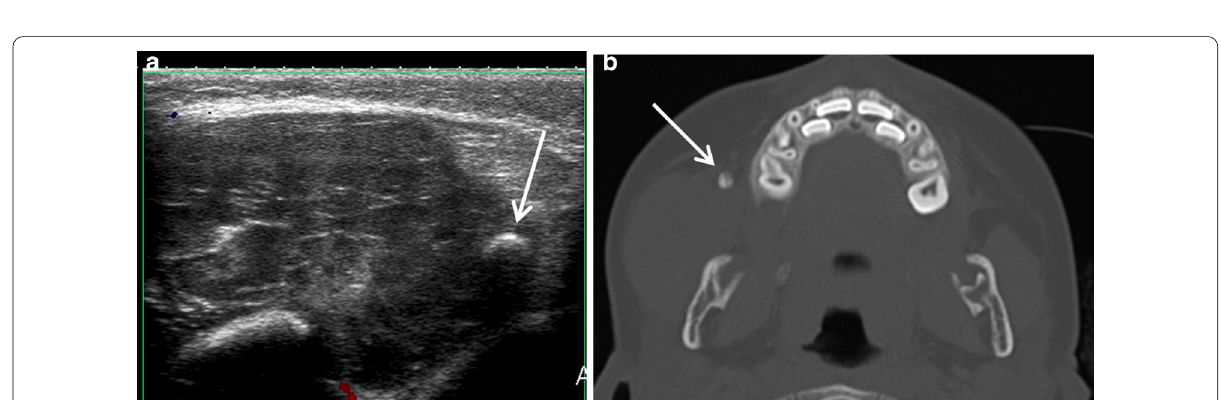
Fig. 24 Venous malformation in the right masseter, with a typical phlebolith, on ultrasonography ( a ) and axial CT image ( b